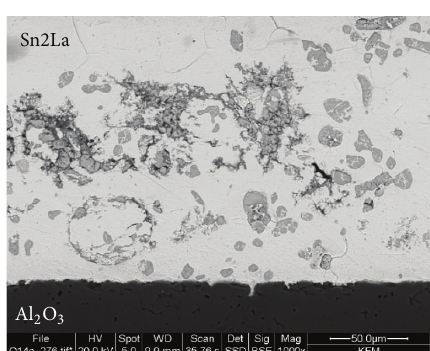
Figure 12: Boundary microstructure of Al 2 O 3 /Sn2La joint after soldering with active